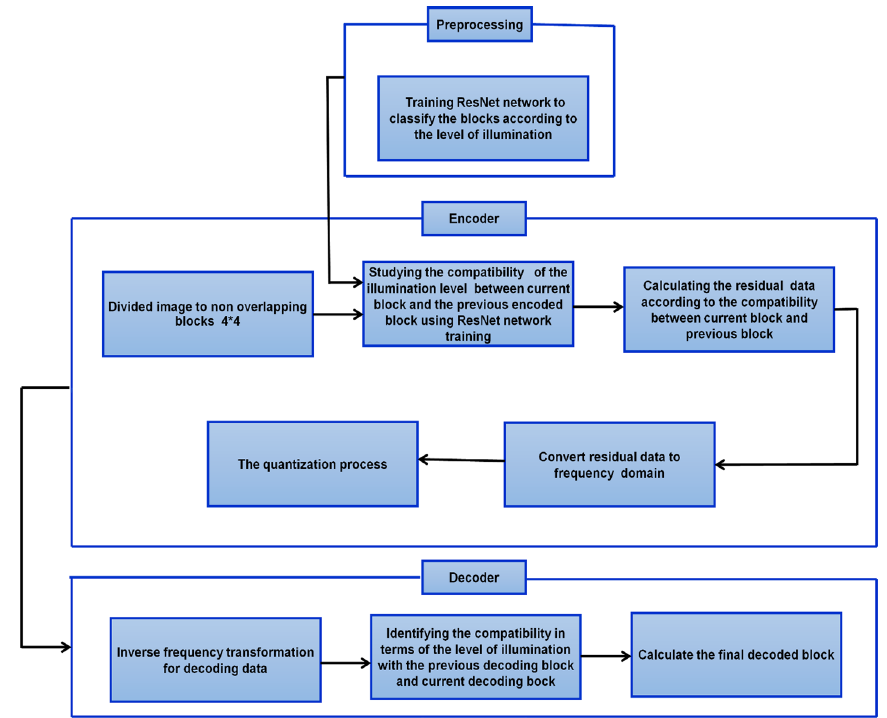
Fig. 5 Block diagram for proposed